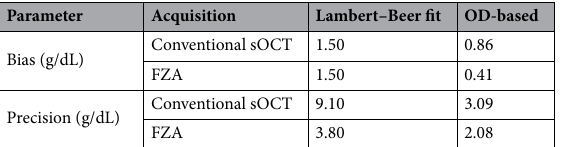
Parameter Acquisition Lambert–Beer fit OD-based Conventional sOCT